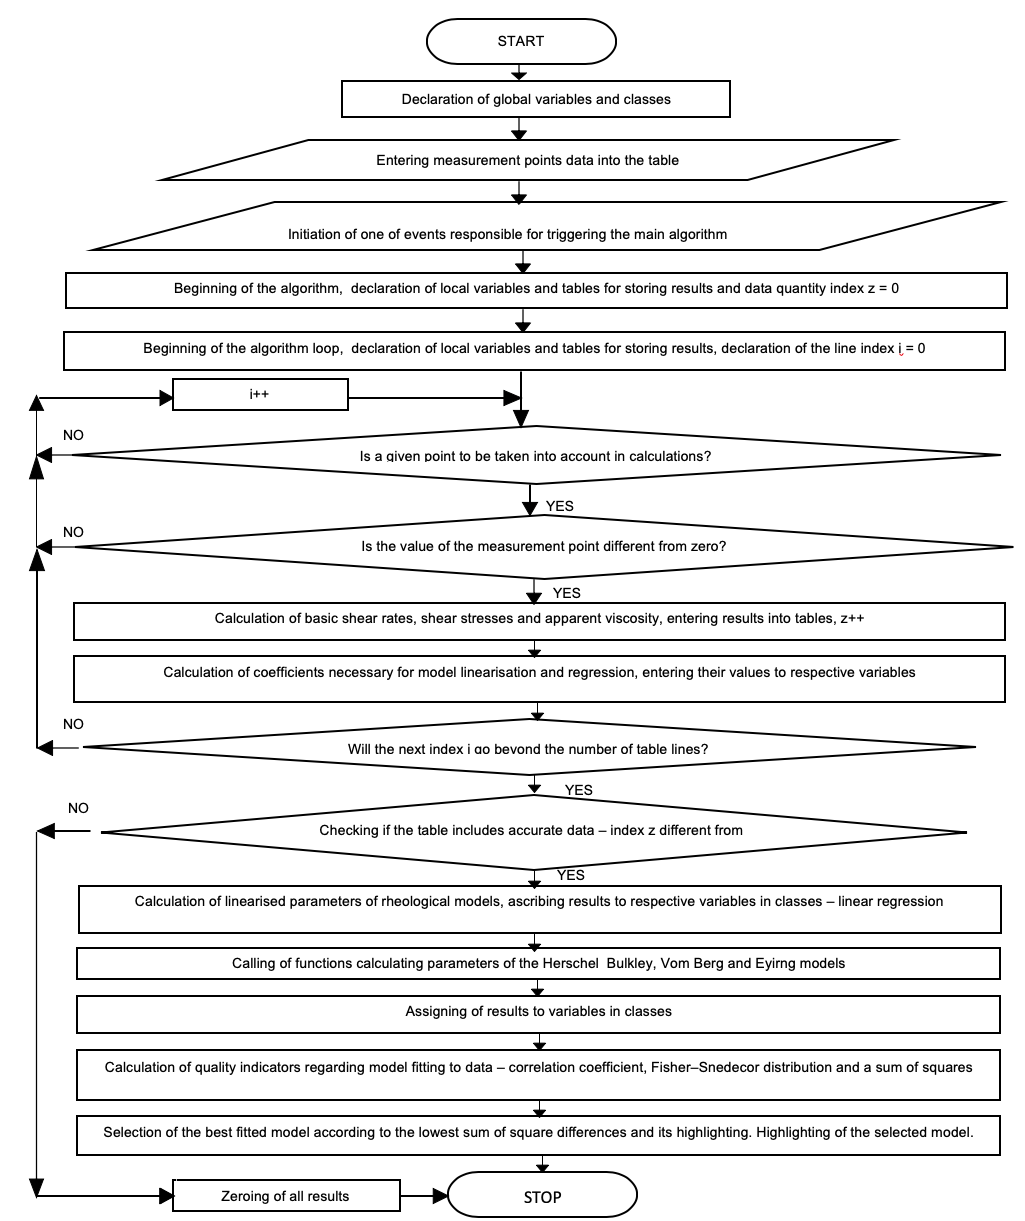
Figure 6. Rheosolution 4.0 block diagram.